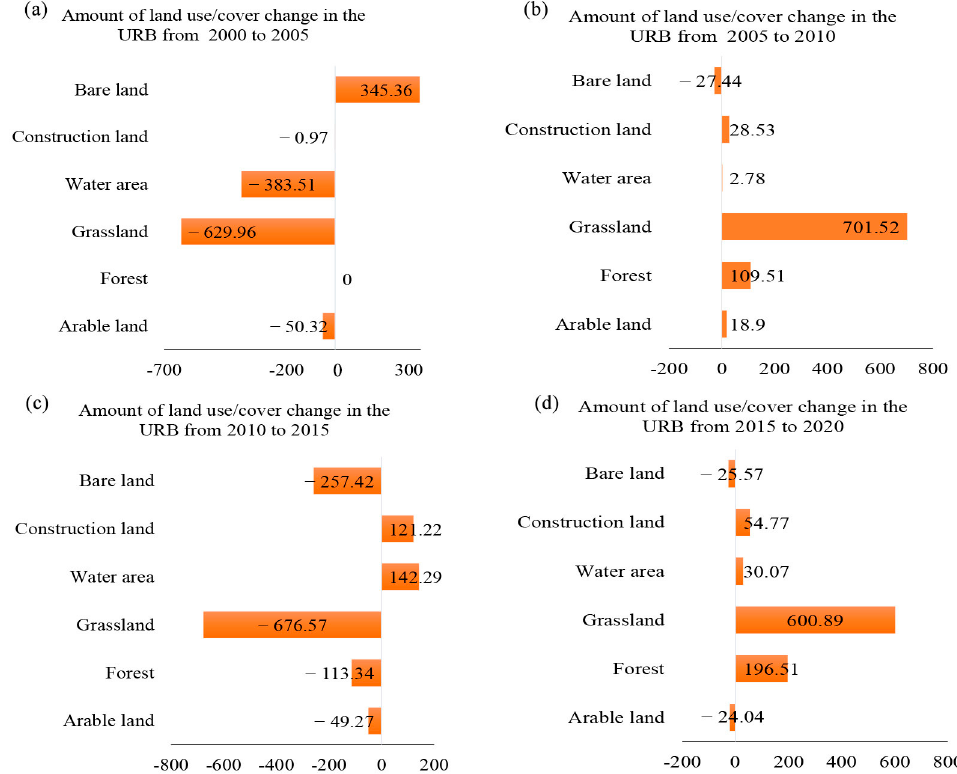
Figure 13. Land-use/cover net change in the URB in different periods: ( a ) 2000–2005, ( b ) 2005–2010, ( c ) 2010–2015, and ( d ) 2015–2020.